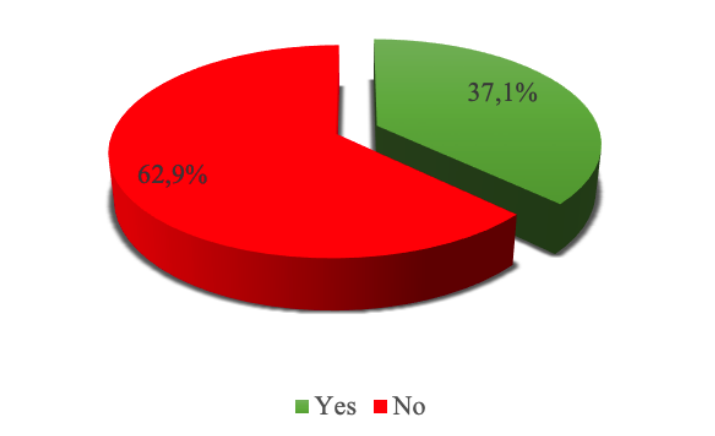
Figure 2 : Completion of